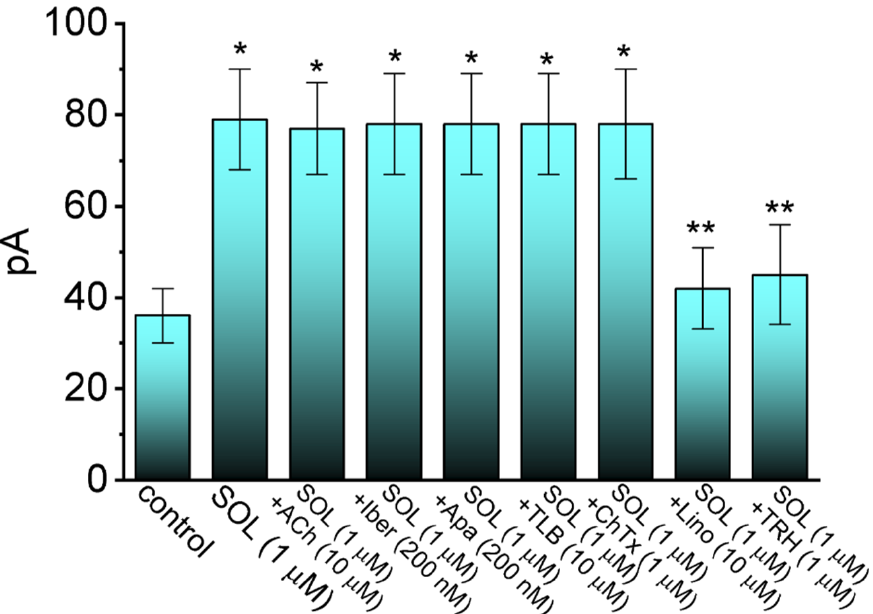
Figure 4. Effect of SOL, SOL plus acetylcholine (ACh), SOL plus iberiotoxin (Iber), SOL plus apamin (Apa), SOL plus tolbutamide (TLB), SOL plus chlorotoxin (ChTx), SOL plus Lino, or SOL plus TRH on the amplitude of I K(M) . In these experiments, we bathed GH 3 cells in high-K + , Ca 2+ -free solution and the recording electrode was filled with K + -enriched (145 mM) solution. Current amplitude was measured at the end of the depolarizing step from − 50 to − 10 mV. Each bar represents the mean ± SEM ( n = 7). * Significantly different from controls ( p < 0.05) and ** significantly different from SOL (1 µ M) alone group ( p < 0.05).